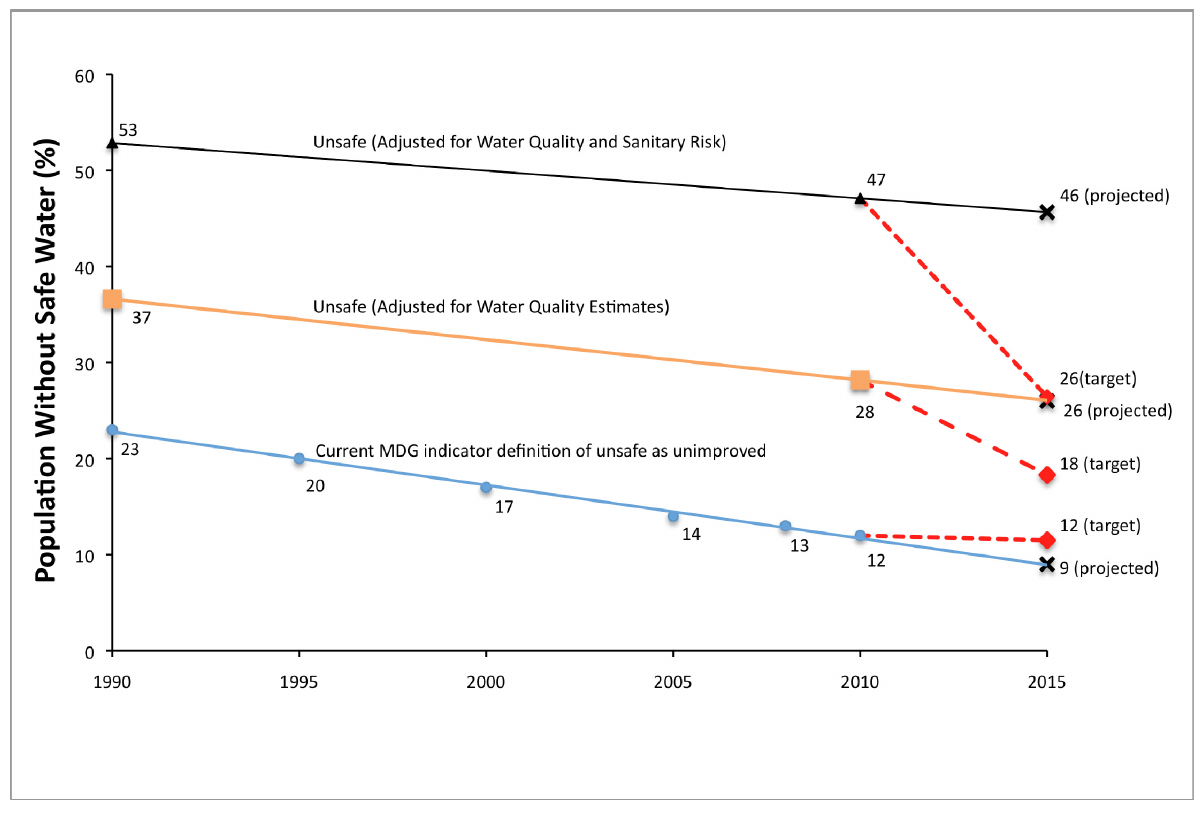
Figure 2. Comparison of MDG Target 7c baseline and target when including and excluding faecal contamination and sanitary risk in water